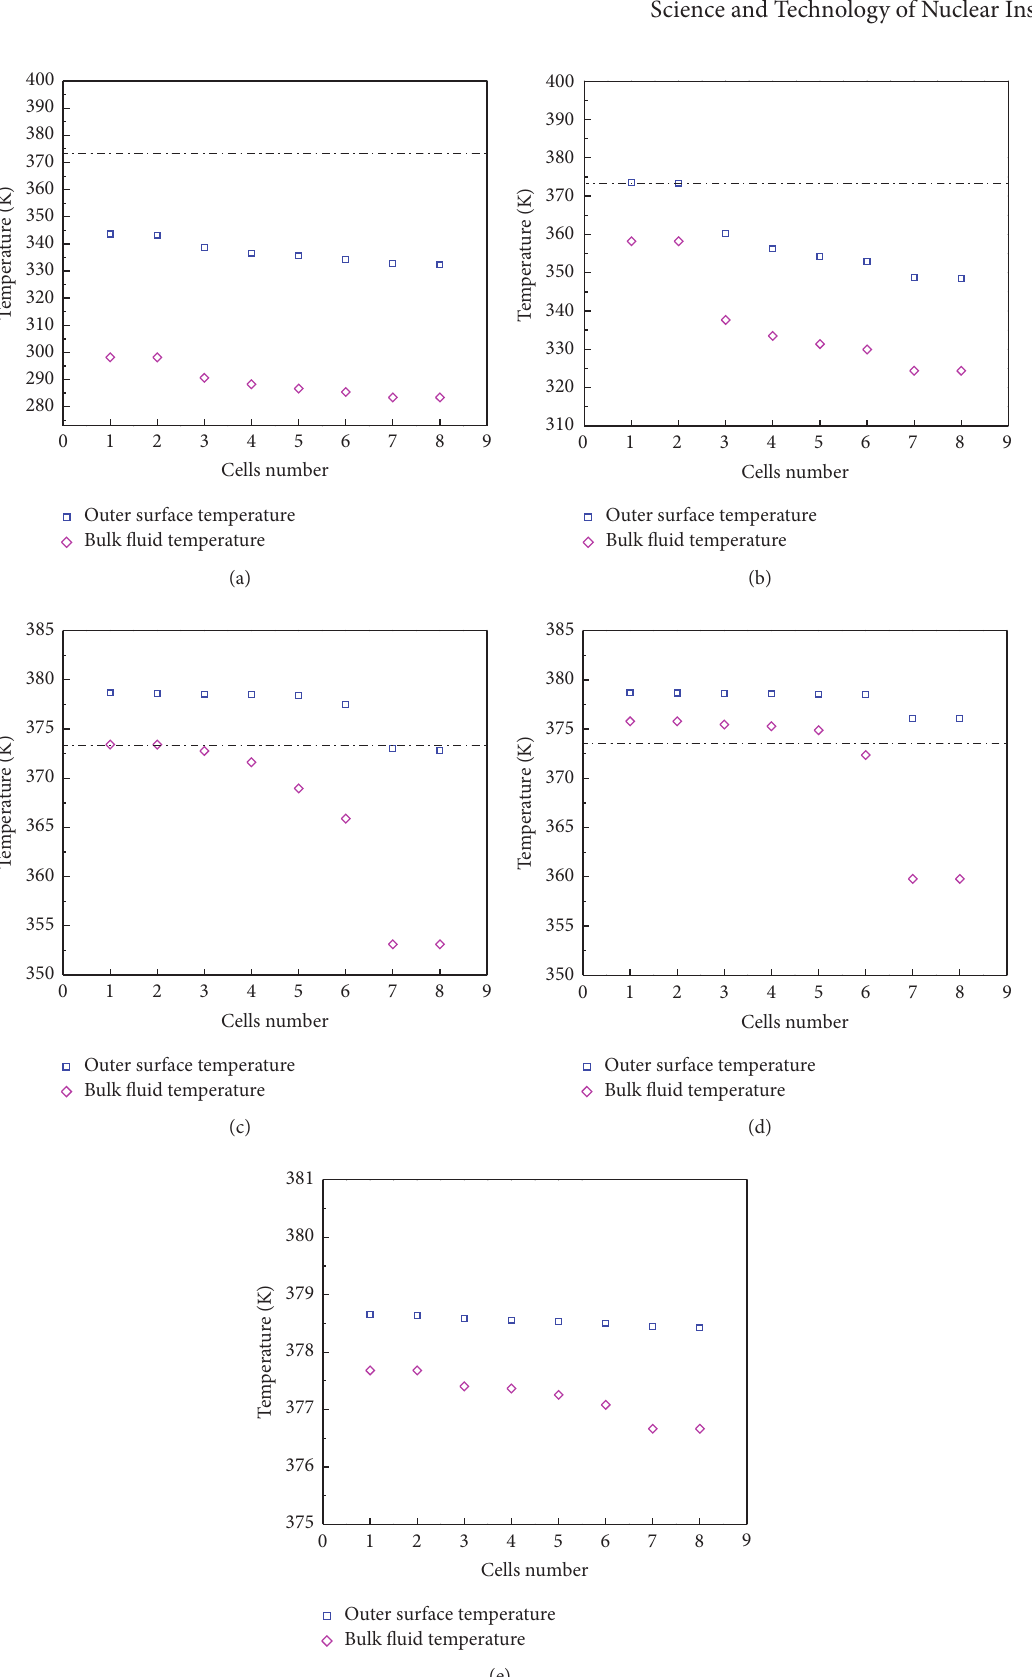
Figure 5: Tube outer surface and tank fluid temperature distribution at different times. (Here the cells number was divided by using tube wall thermocouples position as cells center.) (a) 300s; (b) 6500 s; (c) 12100s; (d) 13000 s; (e)